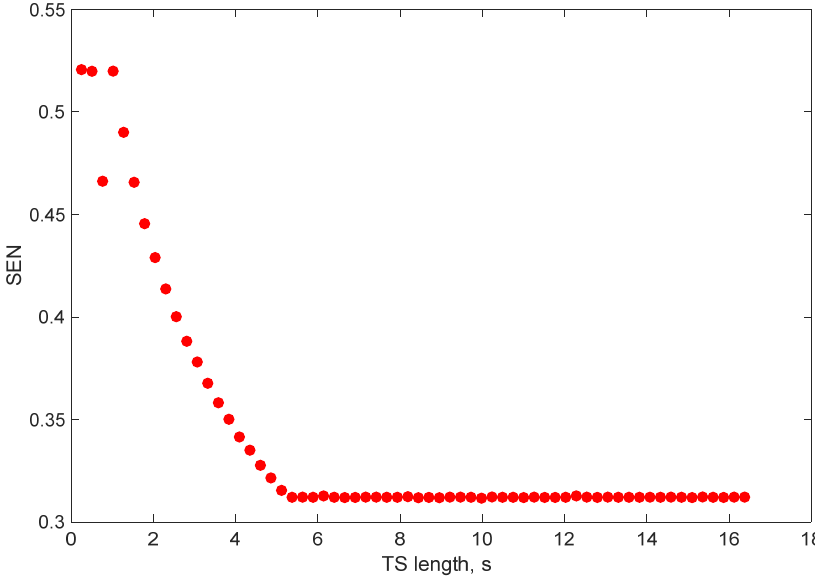
Figure 2. The variation of the SEN with the TS length.